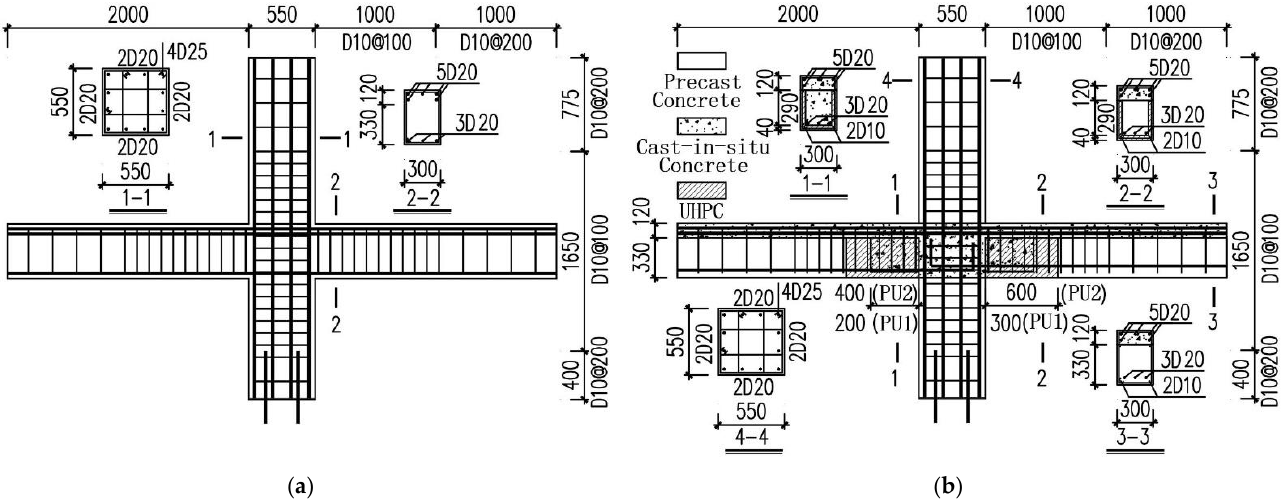
Figure 2. Configurations and reinforcements of the specimens. ( a ) Specimen S1, ( b ) Specimens PU1 and PU2. and